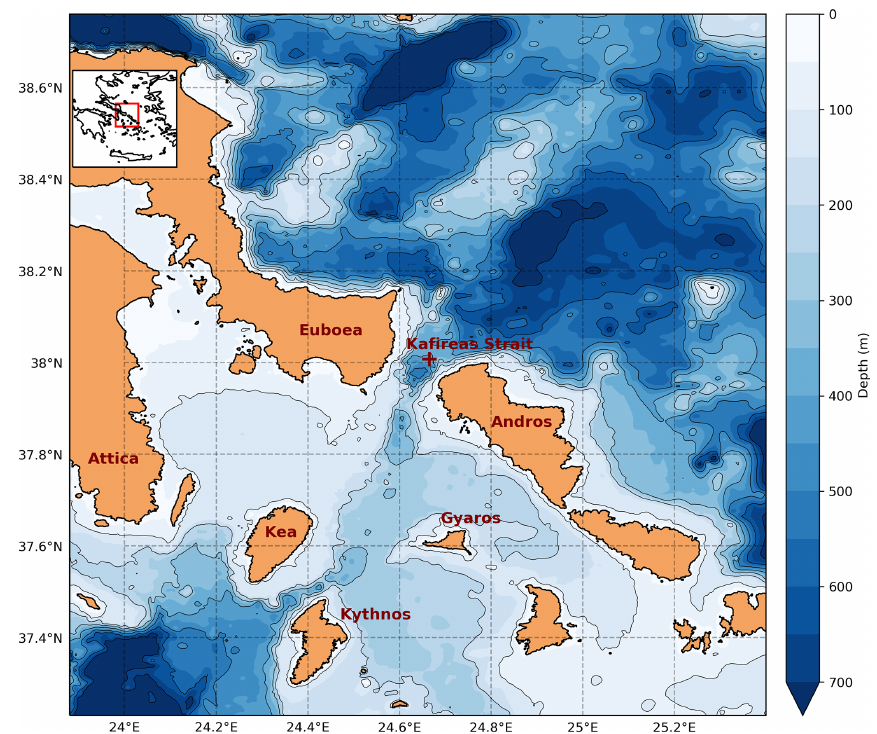
Figure 1. Aegean Sea bathymetry in meters (GEBCO Compilation Group, 2021; Weatherall et al., 2015) and coastlines (Wessel and Smith, 1996) of the study area and oil spill release location at Kafireas Strait (red